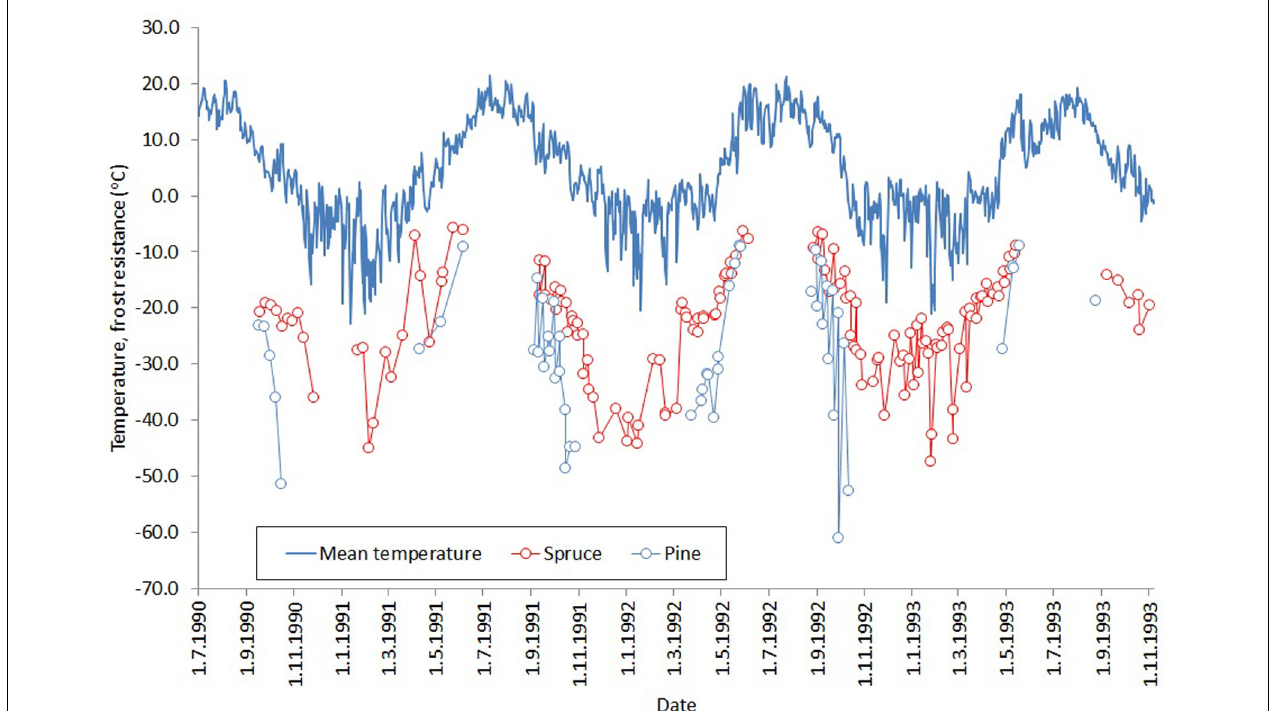
FIGURE 6 | Development of frost resistance of Norway spruce (red) and Scots pine (blue) buds through three winters. The solid line shows the daily mean temperature for the study period. The figure is a combination of